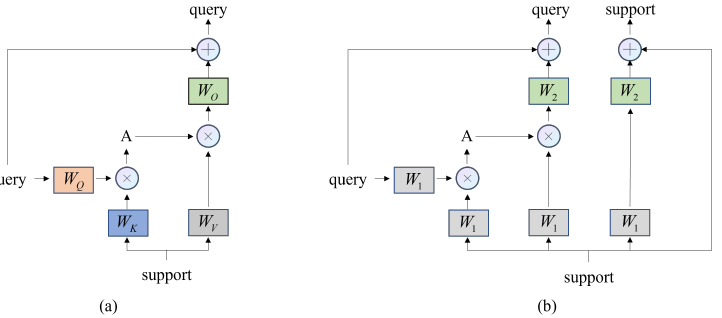
Figure 4. The proposed shared cross-attention module, where W stands for learnable kernels, different footnotes denote different kernels, and A is the attention matrix. ( a ) The vanilla setting and extraction pipeline of cross-attention. ( b ) The pipeline of shared cross-attention module, where query and support features share the same input projection kernel W 1 and output projection kernel W 2